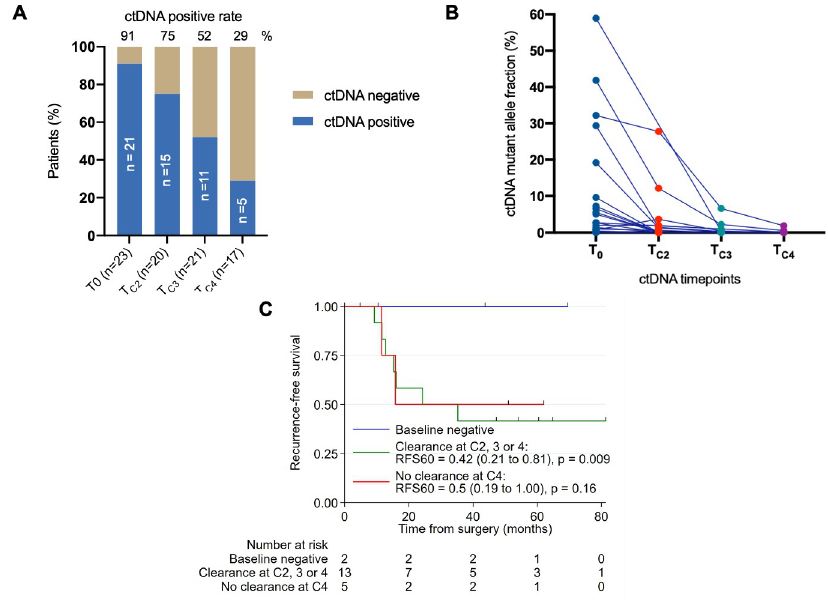
Fig 3. Dynamic changes in ctDNA during neoadjuvant chemo and clinical outcome for cohort 2. (A) ctDNA positive rate at baseline (T 0 ) and before cycle 2, 3, and 4 (T C2 , T C3 , T C4 ). (B) Changes in ctDNA levels for individual patients before cycle 2, 3, and 4 of neoadjuvant chemotherapy. (C) Recurrence-free survival according to ctDNA clearance. ctDNA, circulating tumor DNA; RFS, recurrence-free